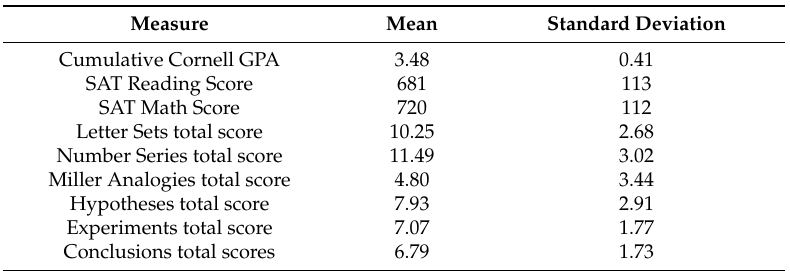
Table 1. Mean scores and standard deviations in Study